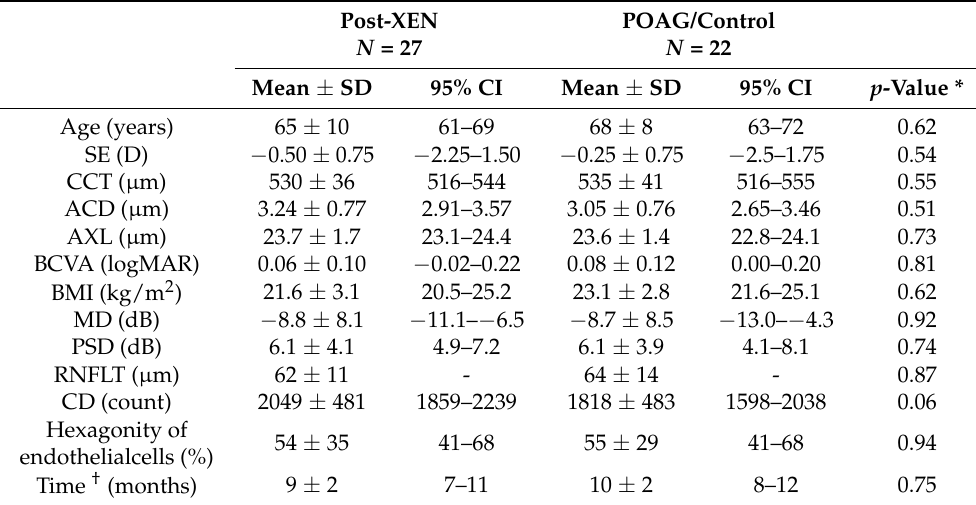
Table 2. Demographic and clinical characteristics of the study groups (post-XEN and POAG). Post-XEN N =